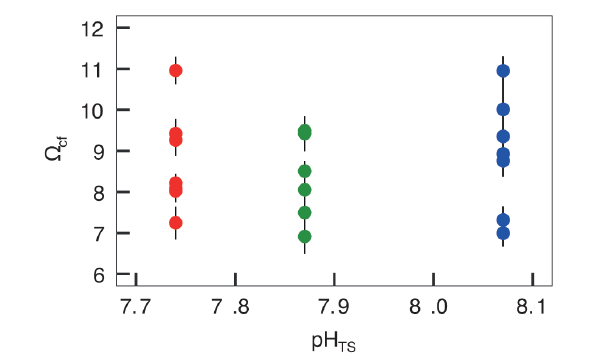
FIGURE 4 | Skeletal aragonite saturation state ( (cid:127) cf ) assessed in Balanophyllia europaea corals growing along the pH TS gradient at Panarea Island. (cid:127) cf was calculated from the average internal pH cf of the individual corals and the DIC cf concentration. Circles represent values for each individual coral (mean ± SEM). Color denotes the different sampling sites: Site 1 = blue, Site 2 = green, Site 3 =